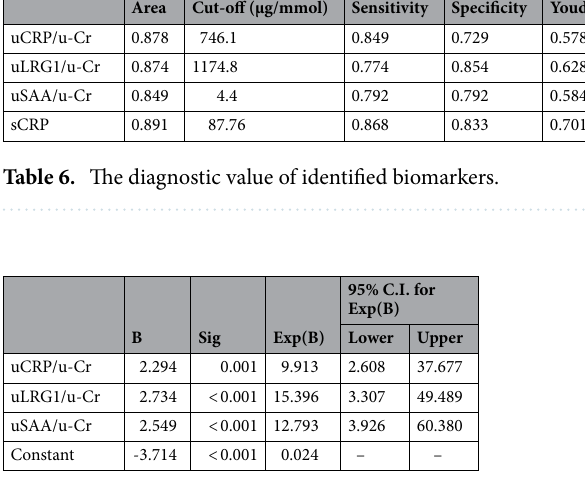
Table 7. Variables in the equation. B regression coefficient, Sig. statistical significance, exp(B) equal to odds ratios, 95% C.I. refers to 95% confidence